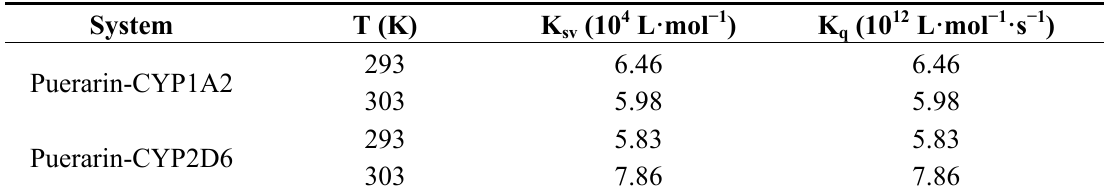
Table 1. Stern-Volmer quenching constants of the systems of puerarin-CYPs at different